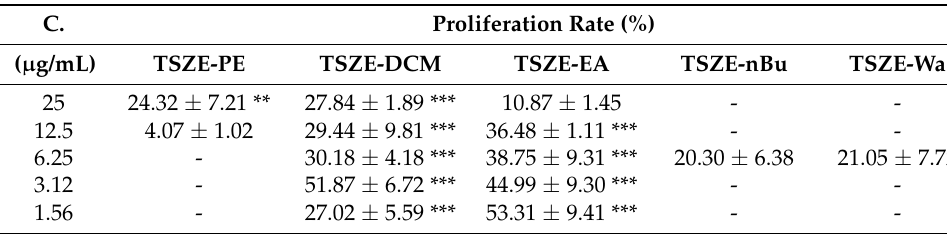
Table 1. Proliferation of NSCs at each isolated part of Cuscuta chinensis .